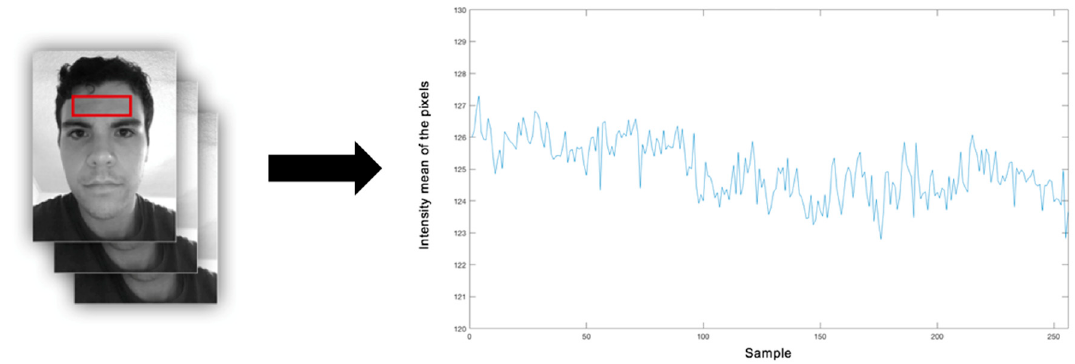
Figure 3. Mean intensity obtained from the pixels in the study area over time.